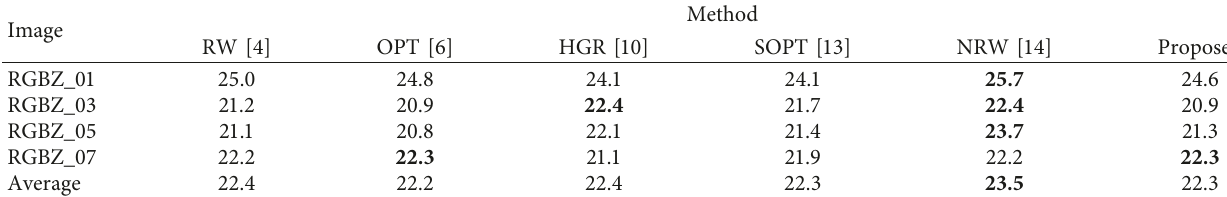
Table 2: PSNR comparison in the absence of inaccurate scribbles.